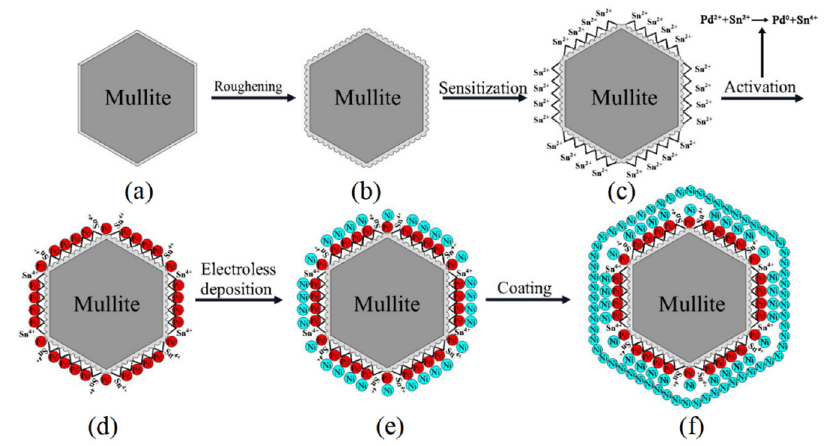
Figure 1. Electroless Ni–P plating.